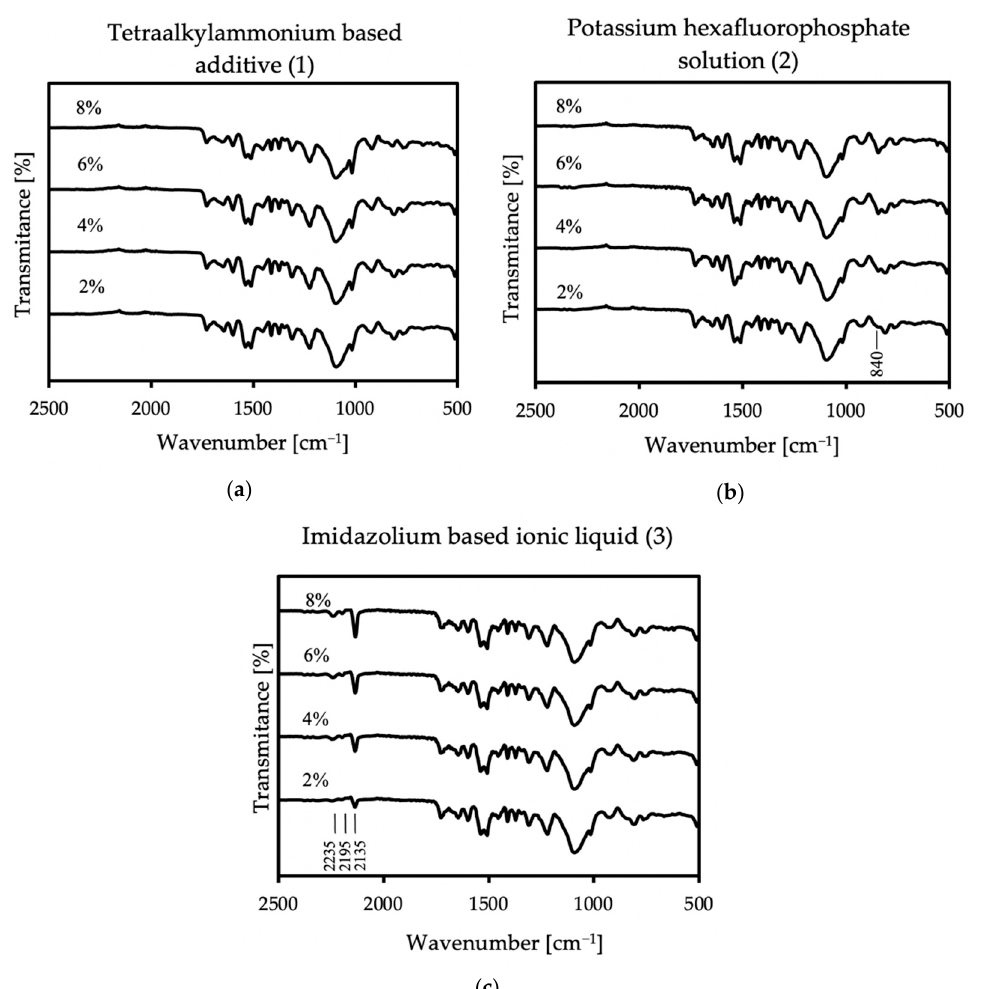
Figure 5 . FT-IR spectra of the coatings with all used concentrations of ( a ) no. 1 additive, ( b ) no. 2 additive, and ( c ) no. 3 additive .